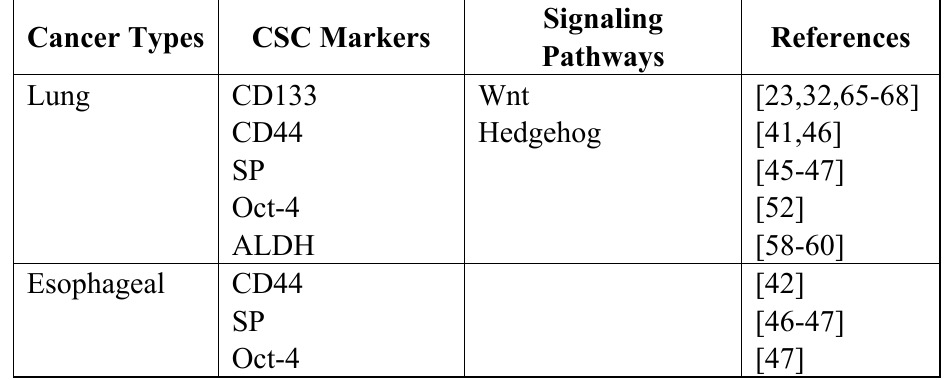
Table 1. Cell markers and signaling pathways of human lung and esophageal cancer stem